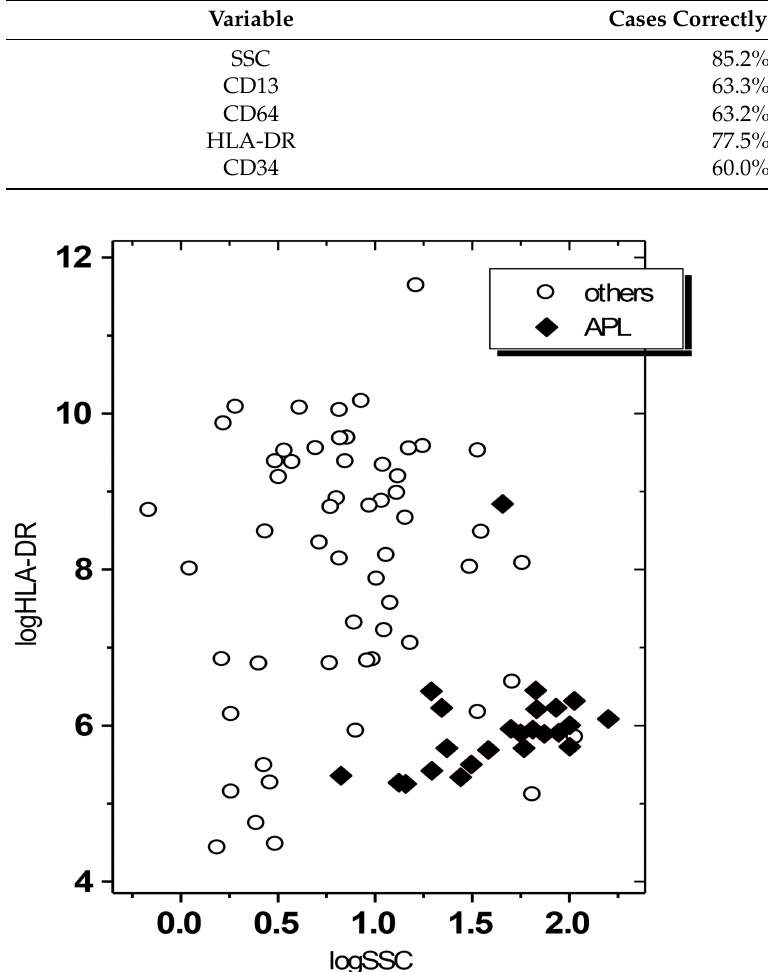
Figure 1. Graphical representation of the distribution of the values of “SSC” and “HLA-DR” that composed the best model: there is little overlap between APL and the non-APL